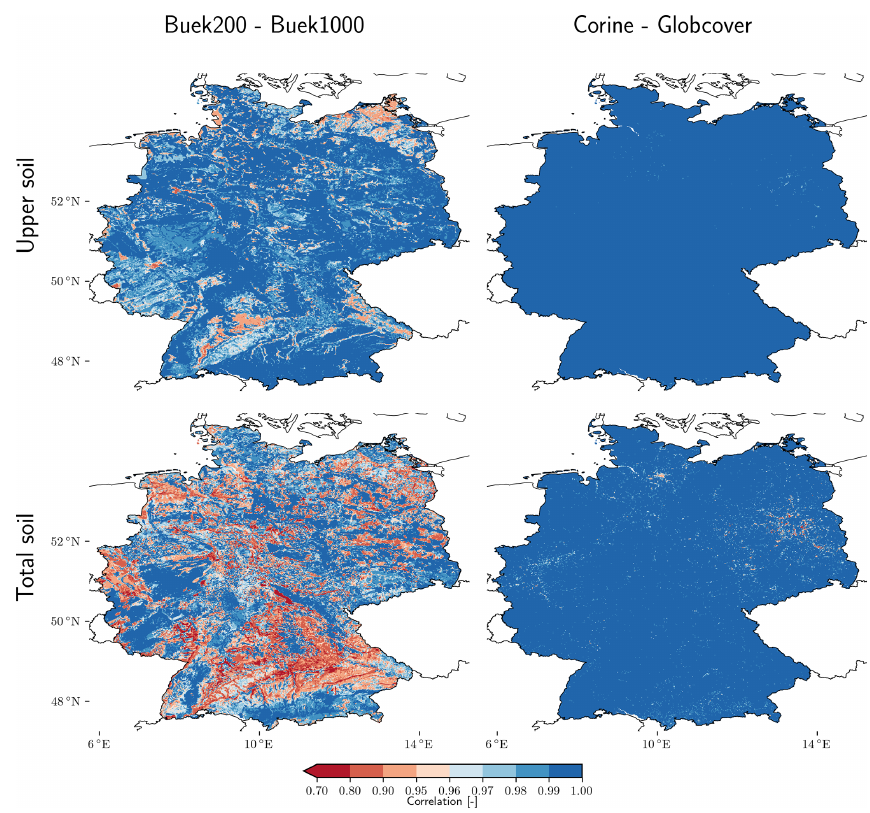
Figure A4. Correlations between simulated daily SM in the upper soil (5–25cm) and the total soil column (up to 2m) using model runs for the time period 1991–2019, keeping the model settings identical (L1 1.2km 2 resolution, default mHM parameters) except for changing the soil dataset BUEK200 versus BUEK1000 (left) and secondly changing land cover dataset CORINE versus GLOBCOVER (right).